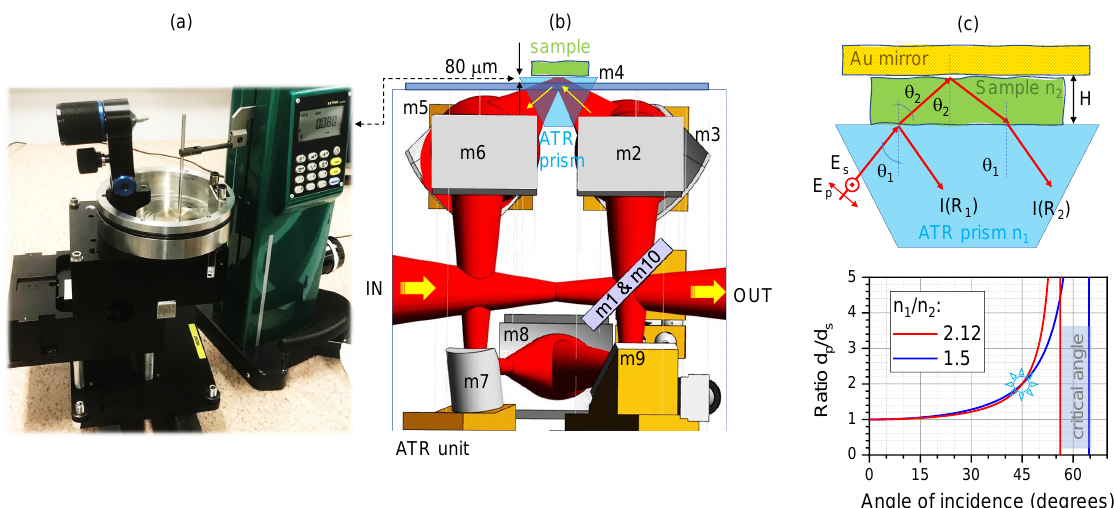
Figure 2. ( a , b ) Photo and schematics of the beam path in ATR unit. Three reflections are encountered from the IN-port to the sample (mirrors m1–3) and extra six for the path sample-to-OUT port (m5–10). (Image: courtesy Dr. Jeff Kuehl) ( c ) Schematics of measurements with top reflecting mirror when TIR conditions are not fulfilled due to the high refractive index n 2 of the sample. Plot shows the evanescent field ratio for the p-pol. (TM) and s-pol. (TE) d p / d s (Equation (3)) vs. the angle of incidence θ i . For the non-polarised illumination, the penetration depth of evanescent field is d ev = d s ) angle is at θ c = arcsin ( n 2 n 1